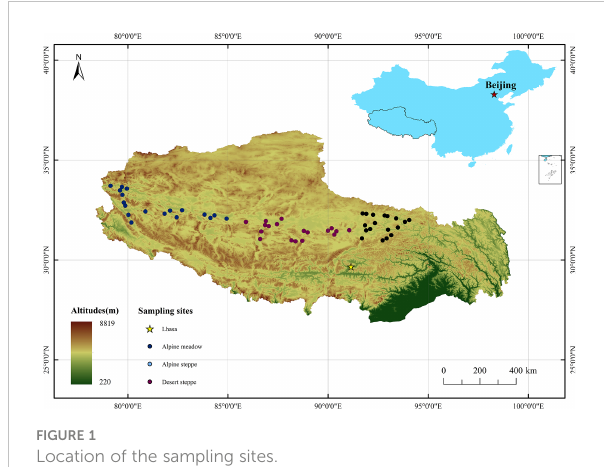
FIGURE 1 Location of the sampling